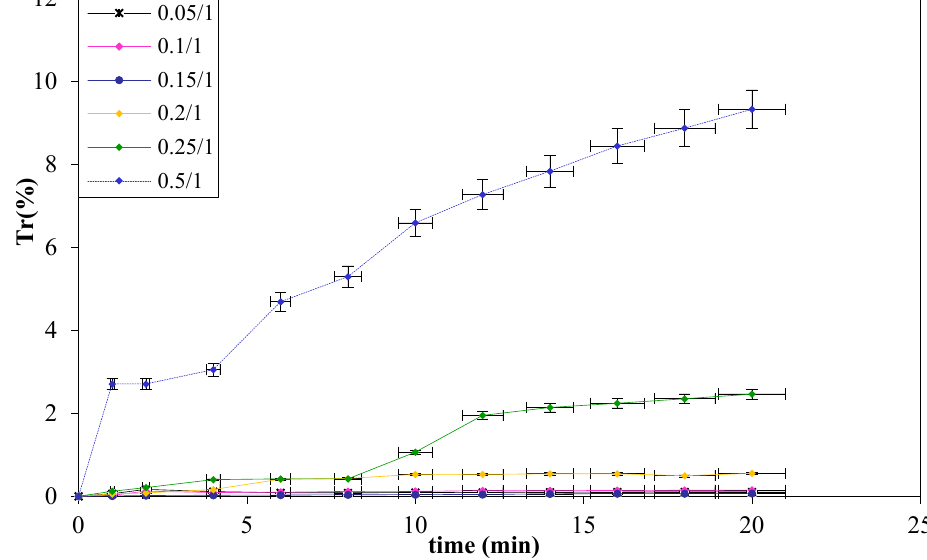
Figure 7. Effect of the ratio of emulsion phase to external phase on emulsion stability (CSpan 80: 2% wt./wt., w: 250 rpm, int/org ( v / v ): (3/4), emu/ext ( v / v ): [0.05/1–0.5/1], t emuls = 3 min, [HNO 3Internal phase ]: 0.5M).